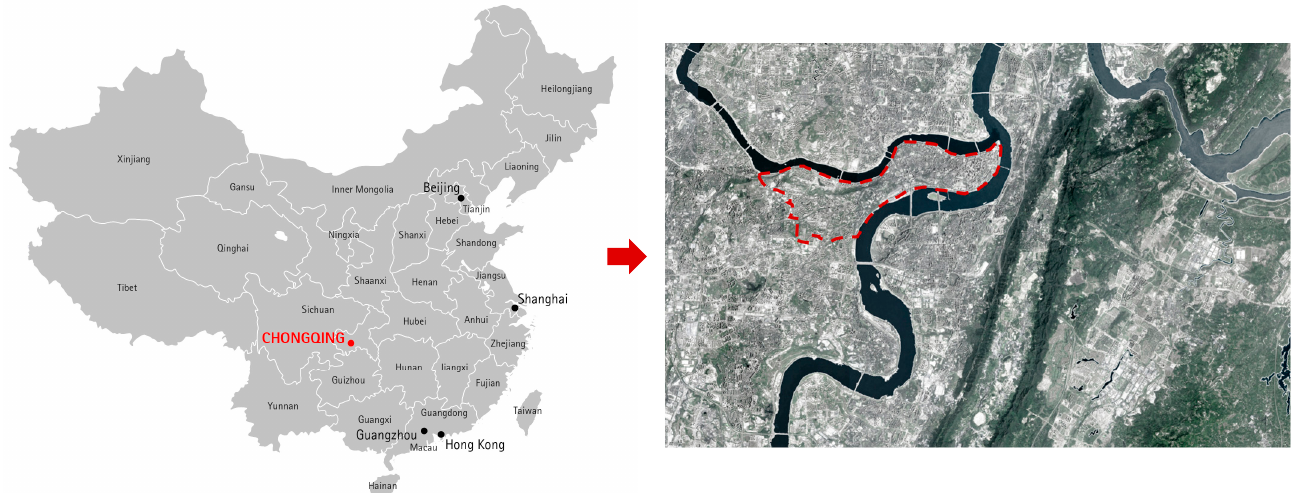
Figure 1. The locations of Chongqing and the Yuzhong Peninsula.